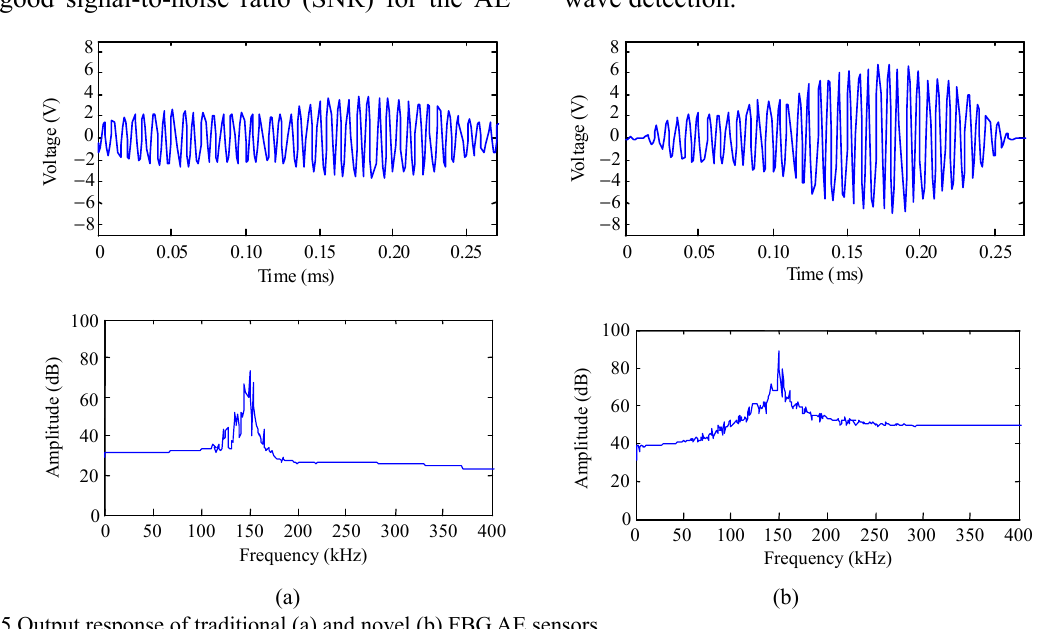
Fig. 5 Output response of traditional (a) and novel (b) FBG AE sensors.